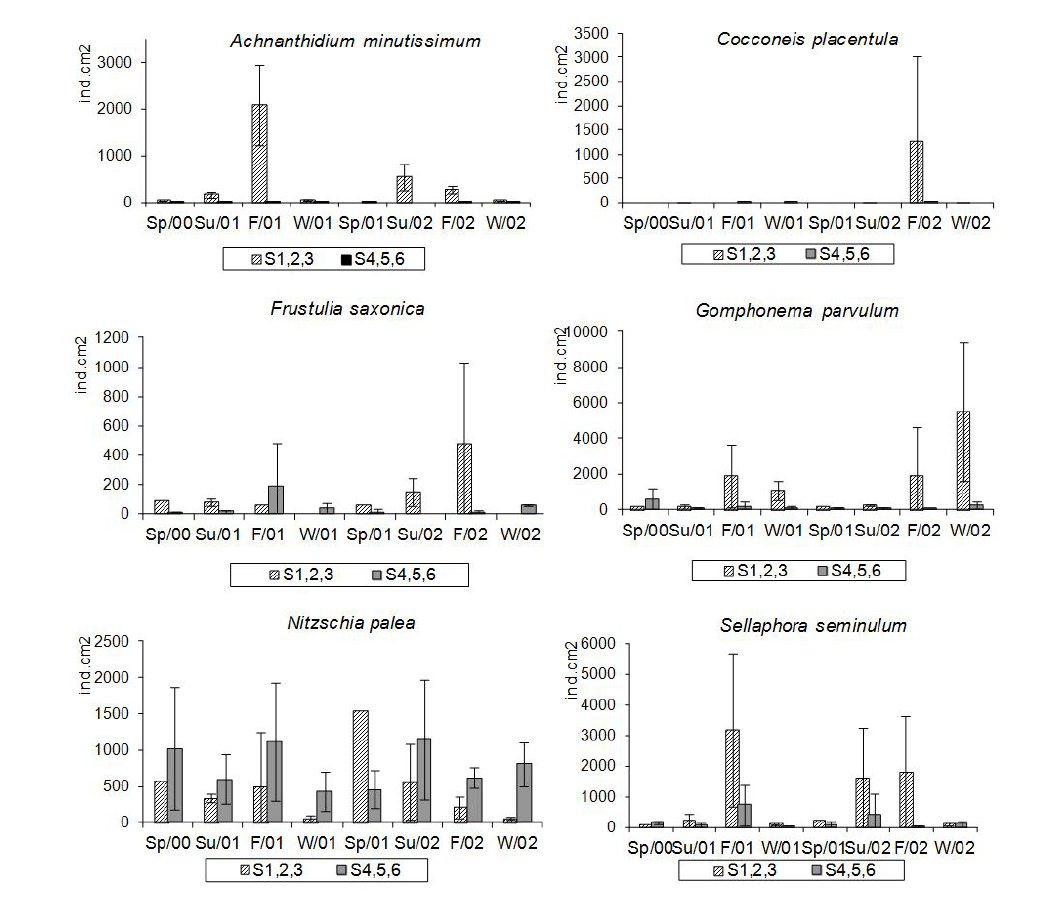
Figure 7. Variation of mean values and standard deviations in the density of the most abundant diatoms (ind/cm 2 ), in the upper (stations 1,2,3) and lower (stations 4,5,6) stretches of the Gravataí river, from September 2000 to August 2002 (Sp=spring; Su=summer; F=fall;